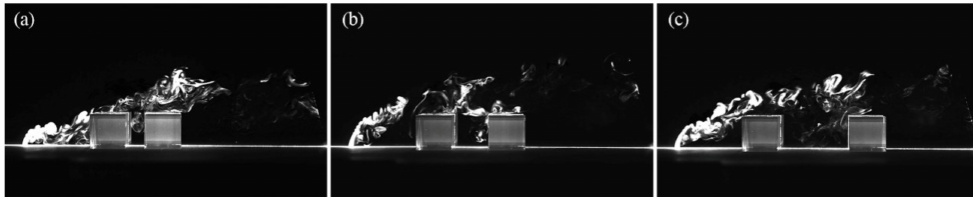
Figure 8. Instantaneous concentration fields on the vertical plane (y = 0) of streets with different aspect ratio: ( a ) R w = 2.0; ( b ) R w = 1.0; ( c ) R w = 0.5.